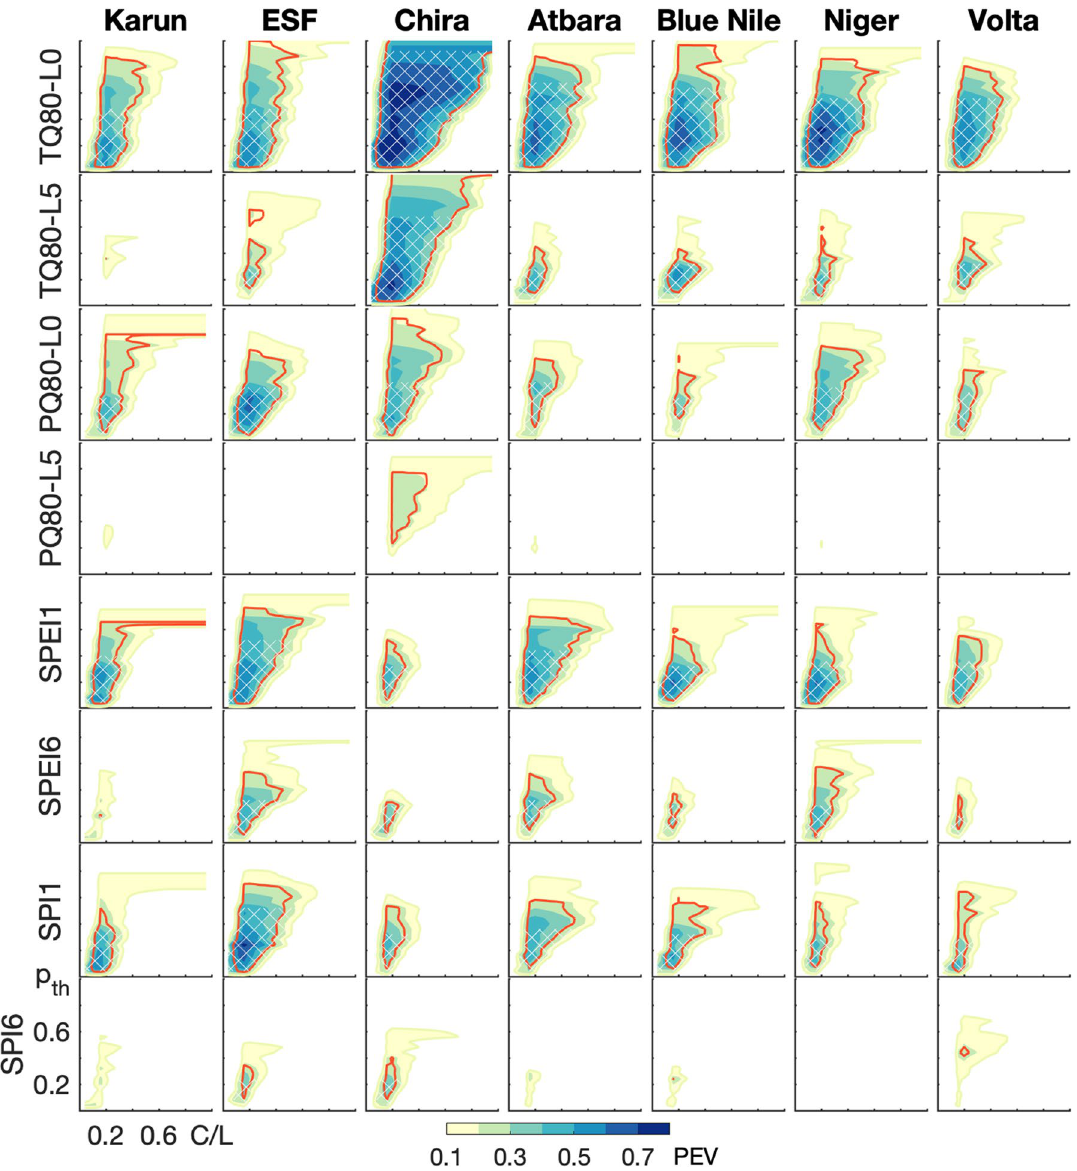
Figure 4. Potential economic value for forecast-based action as a function of probability threshold and user cost-loss ratio. The filled contours denote the potential economic value PEV of SEAS5 with reference ERA5 for extreme events of the seven river basins for rainy seasons of the hindcast period 1981-2016. The extreme events include T > Q 80 and P > Q 80 for leadmonths 0 (L0) and 5 (L5), as well as SPEI < − 1 and SPI < − 1 for aggregation scales over one (SPI1/SPEI1) and 6 months (SPI6/SPEI6). Only valuable conditions are color-coded, i.e., PEV > 0.1 . The uncertainty of the estimation of PEV is assessed with bootstrap resampling, with the red contour indicating where 90% of bootstrap samples give a PEV > 0.1 . The hatched area further represents where PEV > 0.1 and the hit rate H > 0.5 to base the choice of p th on the event maximization potential economic value with increasing lead time than those for wet extreme events ( P > Q80). For warm extreme events, Lead 0 forecasts attain maximum potential economic values between 0.55 and 0.8, whereas for wet extreme events, PEV max of Lead 0 forecasts ranges between 0.38 and 0.64. The uncertainty of PEV max estimation is taken into account with the bootstrap confidence range (dashed lines in Fig. 6), e.g., specifying a range of 0.64 < PEV max < 0.98 for warm extreme events of Lead 0 in Chira with the 10% and 90% of bootstrap percentiles. Except for Chira with a smooth decrease of maximum potential economic value for warm extreme events with lead time, all regions show an abrupt decline of PEV max from Lead 0 to Lead 1. For most regions, this strong drop is larger than the decline of PEV max from Lead 1 to Lead 5. The most abrupt drop of PEV max is evident for wet extreme events in ESF from 0.75 of Lead 0 to 0.24 of Lead 1. For drought conditions, the decline with longer aggregation scales is less pronounced than the decline with single lead times for the wet extreme, as still higher-valued months of lower forecast horizon are included in SPI/SPEI. In basins like ESF, Blue Nile